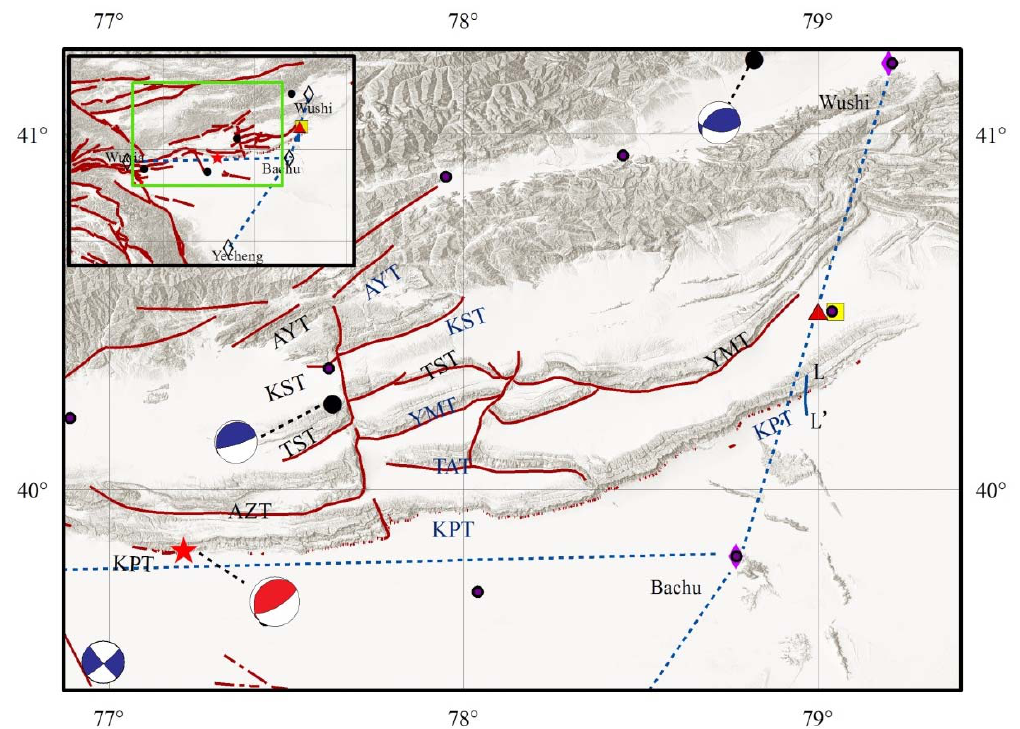
Figure 1. Main faults in the Atushi–Kalpin Thrust Zone and the locations of geophysical observatories. Red lines indicate active faults, including the Kalpintag Thrust Fault (KPT), Aozigertawu Thrust Fault (AZT), Toksanatanengbayler Thrust Fault (TST), Kekebuke Sanshan Thrust Fault (KST), Aoyibulake Thrust Fault (AYT), Tataiertage Thrust Fault (TAT), and Yimugantawu Thrust Fault (YMT) [39]. The red triangle indicates the location of the Kalpin Apparent Resistivity Observatory, the yellow square indicates the location of the Kalpin Meteorological Observatory, and the dashed blue lines denote the crustal deformation baselines. Black dots indicate GPS observation sites and LL’ represents the geochemical survey line.